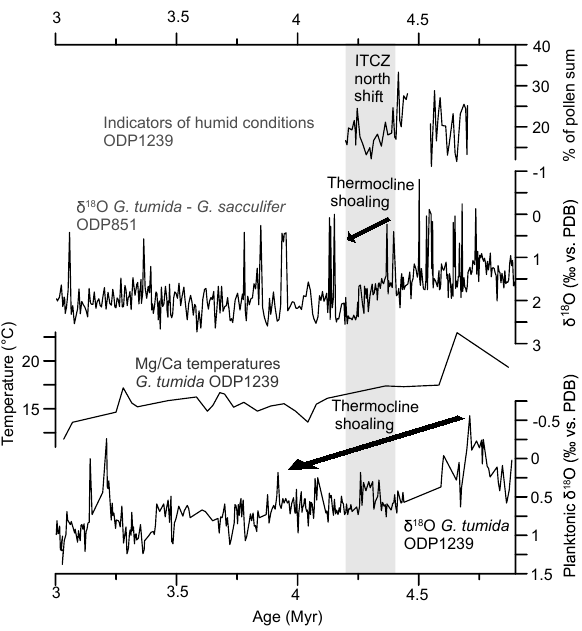
Figure 7. Percentages of indicators of humid conditions (ODP Site 1239, this study), G. tumida – G. sacculifer difference in δ 18 O from ODP Site 851 in the eastern equatorial Pacific (Cannariato and Rav- elo, 1997), and G. tumida Mg / Ca temperatures and δ 18 O from ODP Site 1239 (Steph, 2005; Steph et al., 2010). Grey shading marks the period of thermocline shoaling at ODP Site 851 and ITCZ north